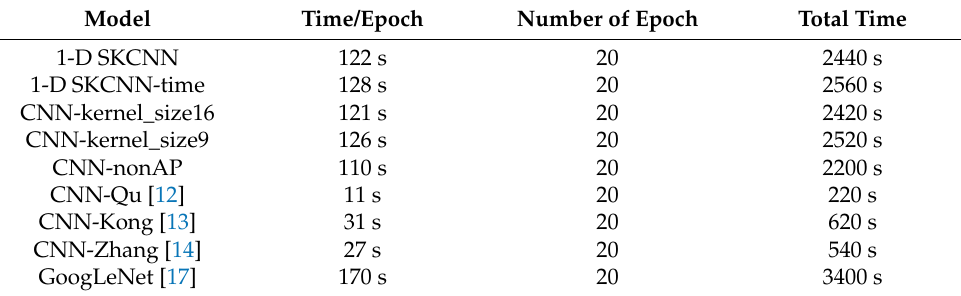
Table 5. The time usage for training the model in different